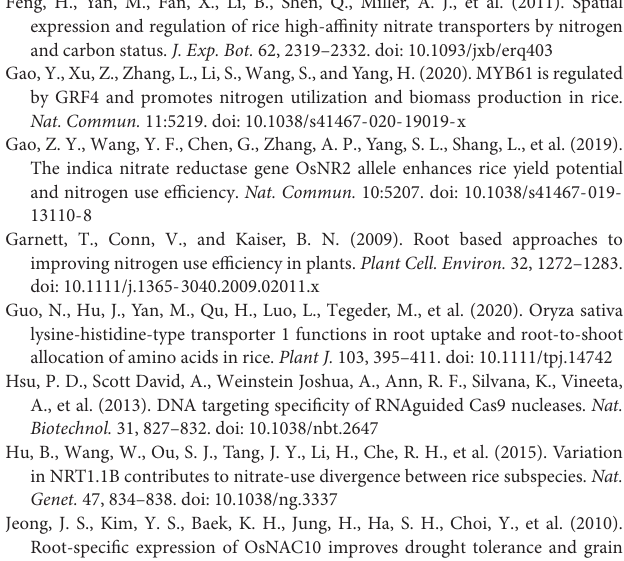
Supplementary Table 5 | LNA, HNA, LNUE, and HNUE of nitrogen-inefficient and nitrogen-efficient varieties. Supplementary Table 6 | Annotated genes in the QTLs region.